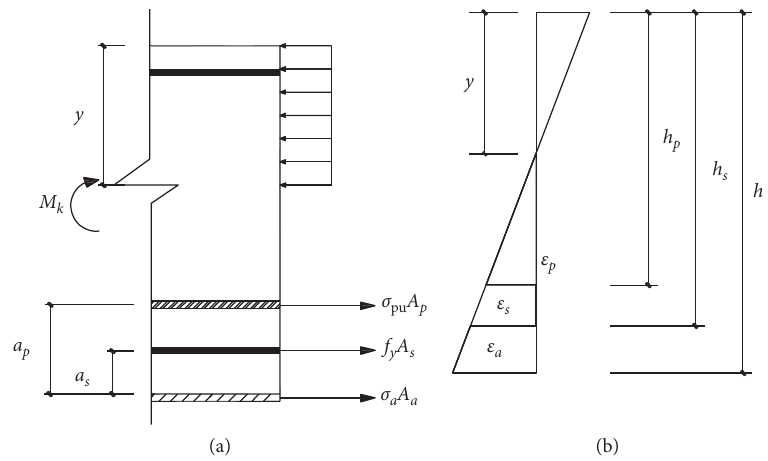
Figure 12: The distribution of stress and strain of the section in serviceability